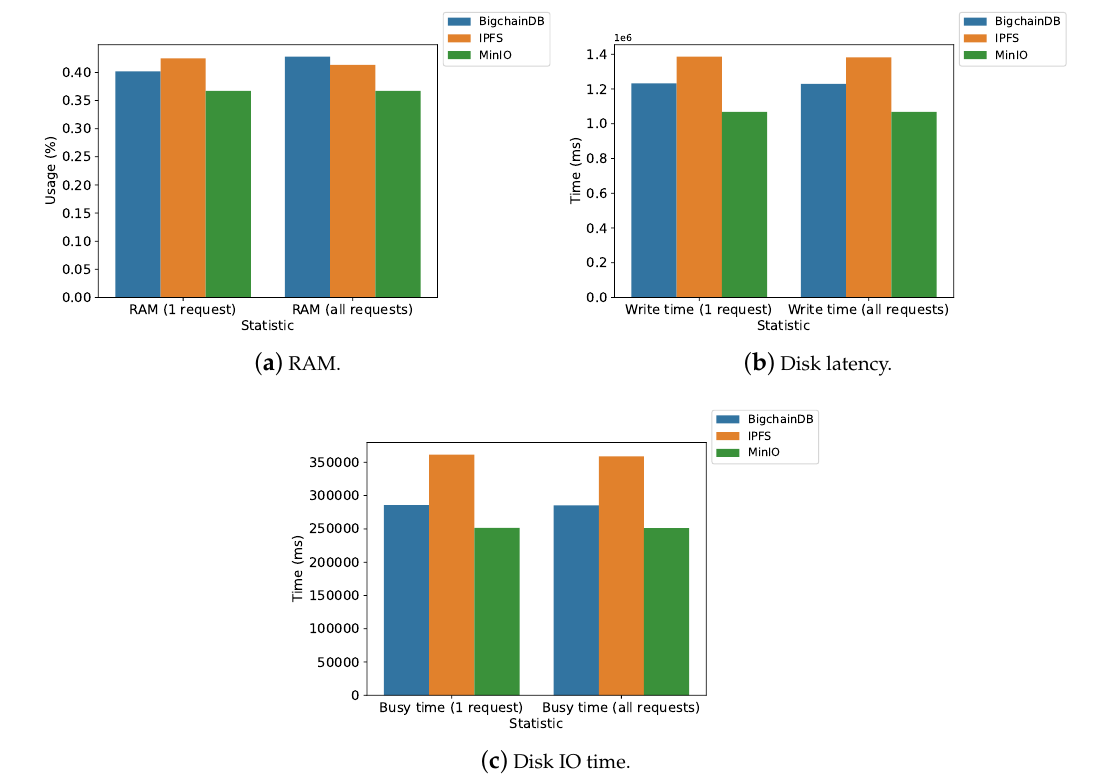
Figure 2. Statistics for the read operation of each database.